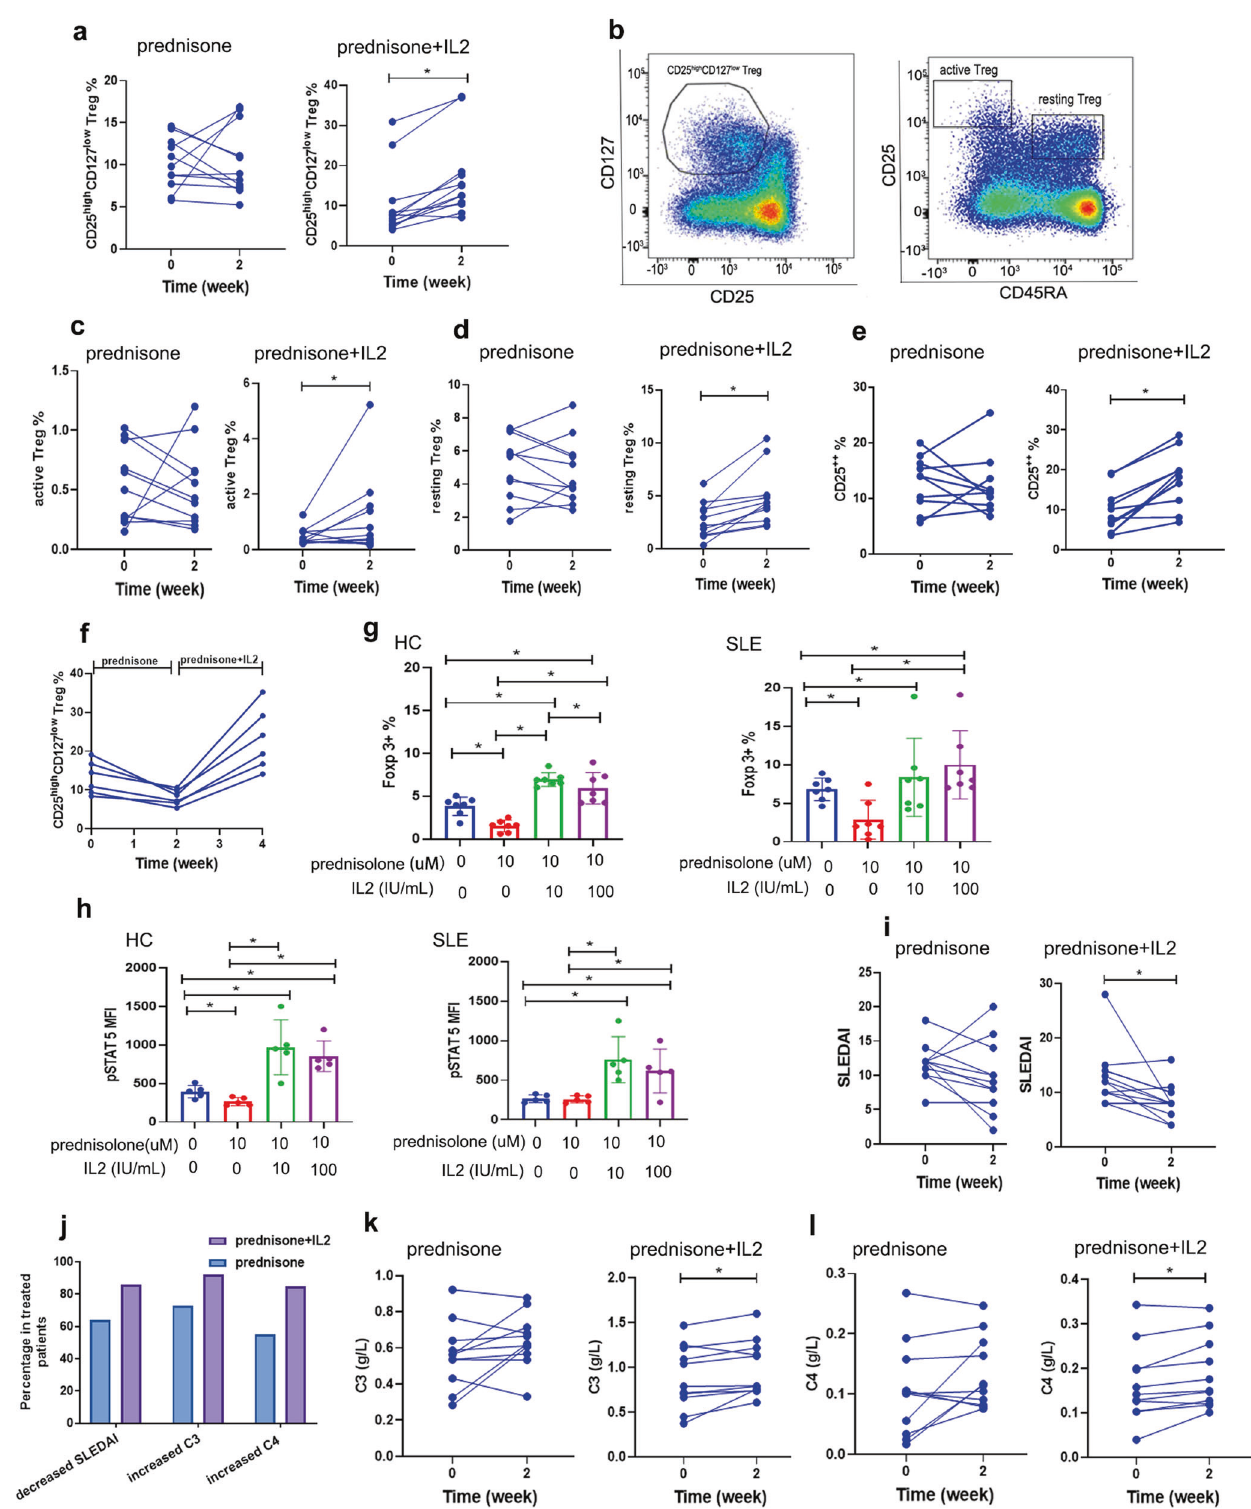
Fig. 1 Differential effects of prednisone with or without IL-2 supplementation on Treg subsets and disease improvement in SLE patients. a Shows the percentages of CD25 high CD127 low Treg before and after 2 weeks of treatment. b Treg were gated as CD25 high CD127 low in CD4 + T cells. Treg subsets were de fi ned based on the expression of CD45RA and CD25: CD45RA - CD25 +++ active Treg, CD45RA + CD25 ++ resting Treg. c , d Show the percentages of active Treg and resting Treg before and after 2 weeks of treatment. e Shows the expression of CD25 before and after 2 weeks of treatment. f Shows the reduced Treg levels in patients treated with prednisone alone were rescued by the addition of low-dose IL-2. g , h Show that IL-2 restored prednisolone-induced decrease on expression of ( g ) Foxp3 and ( h ) pSTAT5 in vitro. j The percentages of patients with decreased SLEDAI and increased C3 and C4 was compared between prednisone and prednisone + IL-2. i SLEDAI score, levels of ( k ) C3 and ( l ) C4 of SLE patients before and after 2 week treatment with prednisone with/without IL-2 are shown Signal Transduction and Targeted Therapy (2023)